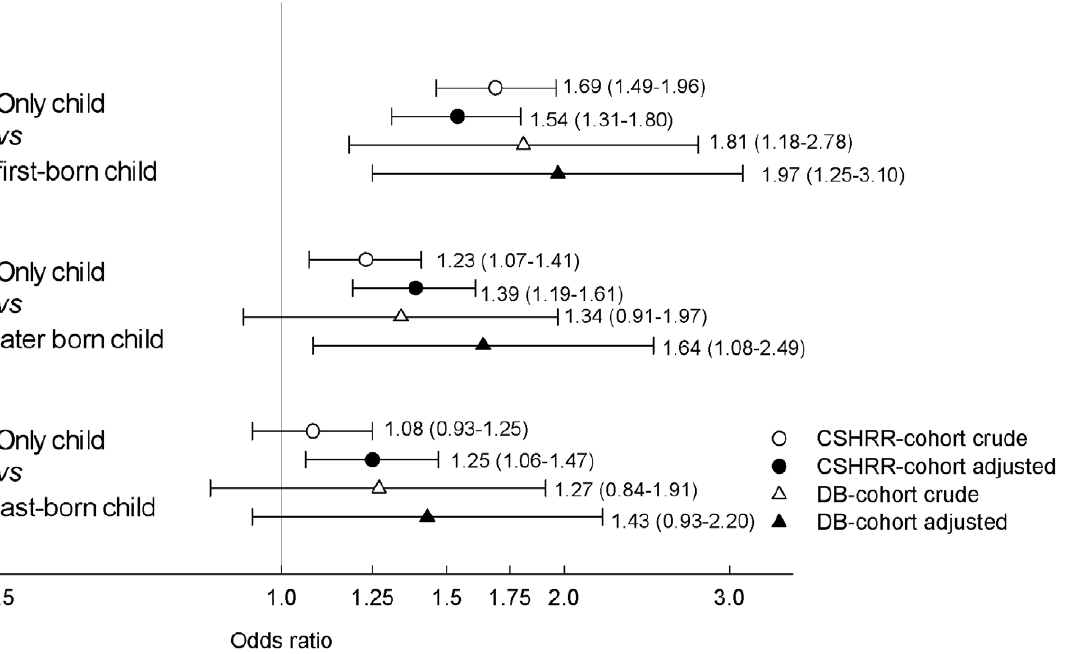
Figure 2. Odds of obesity by only child status vs. first-, later and last-born child, respectively. Crude and adjusted results (Odds ratio (95% CI)) for the Copenhagen School Health Records Register (CSHRR) cohort 1 as well as the Draft Board (DB) cohort 2 are shown, respectively. The adjusted results are adjusted for birth weight, birth year, 1 sex, 1 maternal age, 1 maternal BMI (age 13 years) and 2 father’s social class.